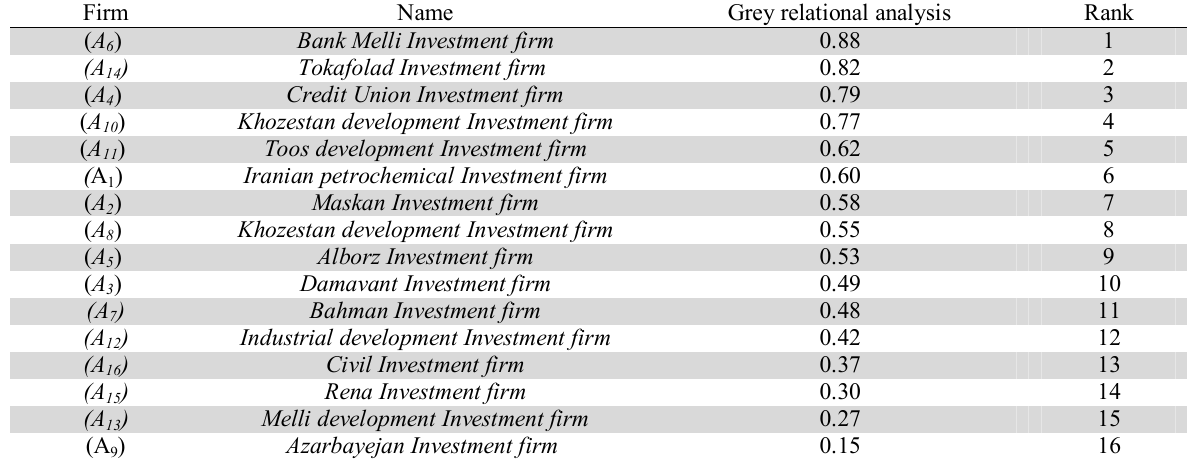
The summary of grey relational analysis for 16